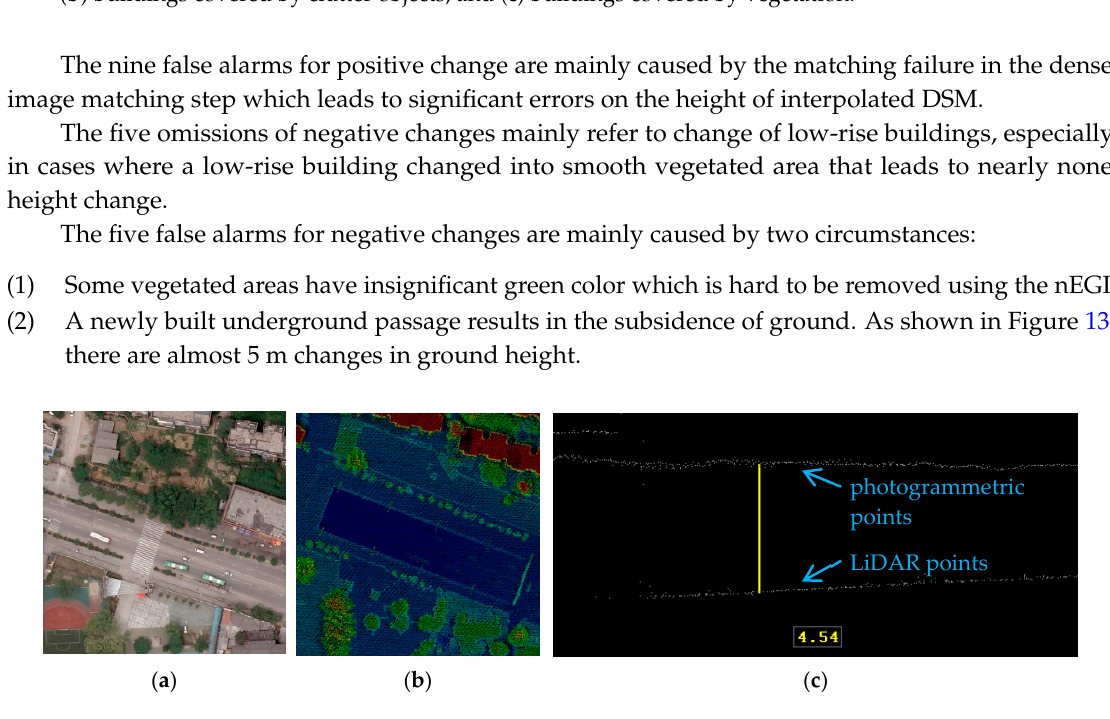
Figure 12. Examples of omissions for positive change: ( a ) buildings with complex structures of roof; ( b ) buildings covered by clutter objects; and ( c ) buildings covered by vegetation.